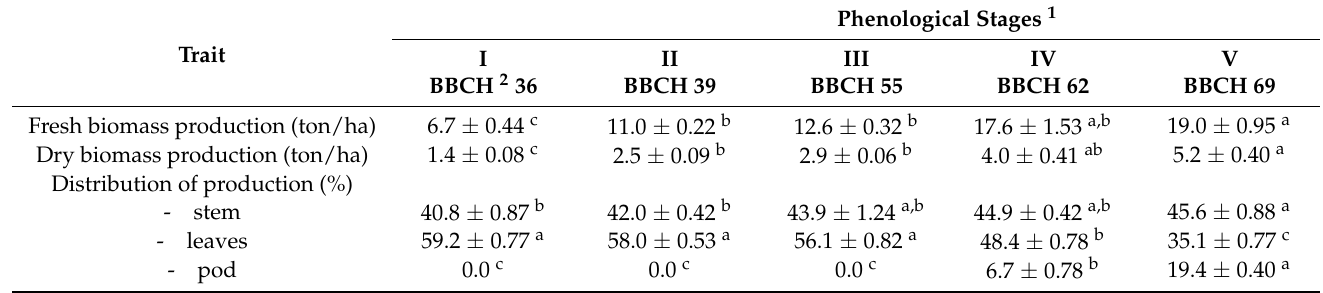
Table 3. Productive performances of Camelina sativa harvested during phenological stages (average between the two test years) (mean ± standard error).